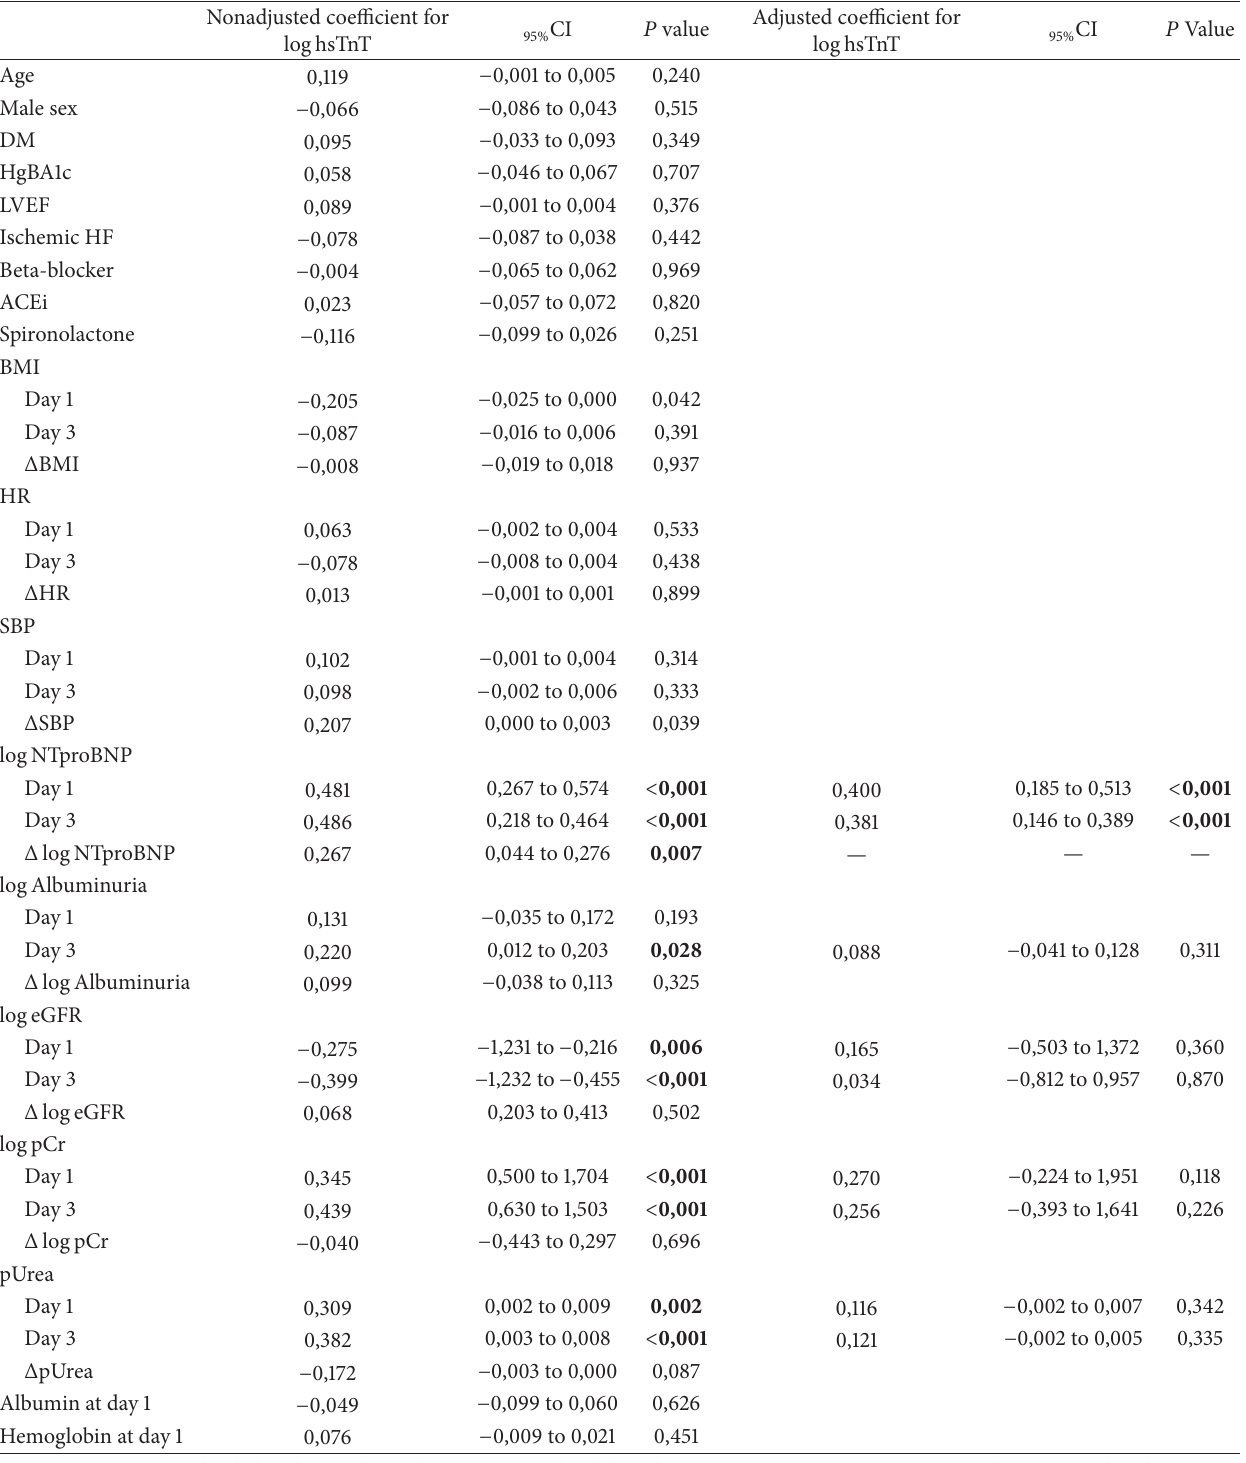
Table 4: Associations with loghsTnT at day 1, day 3 and changes between day 1 and day 3 ( Δ ). Nonadjusted coefficient for